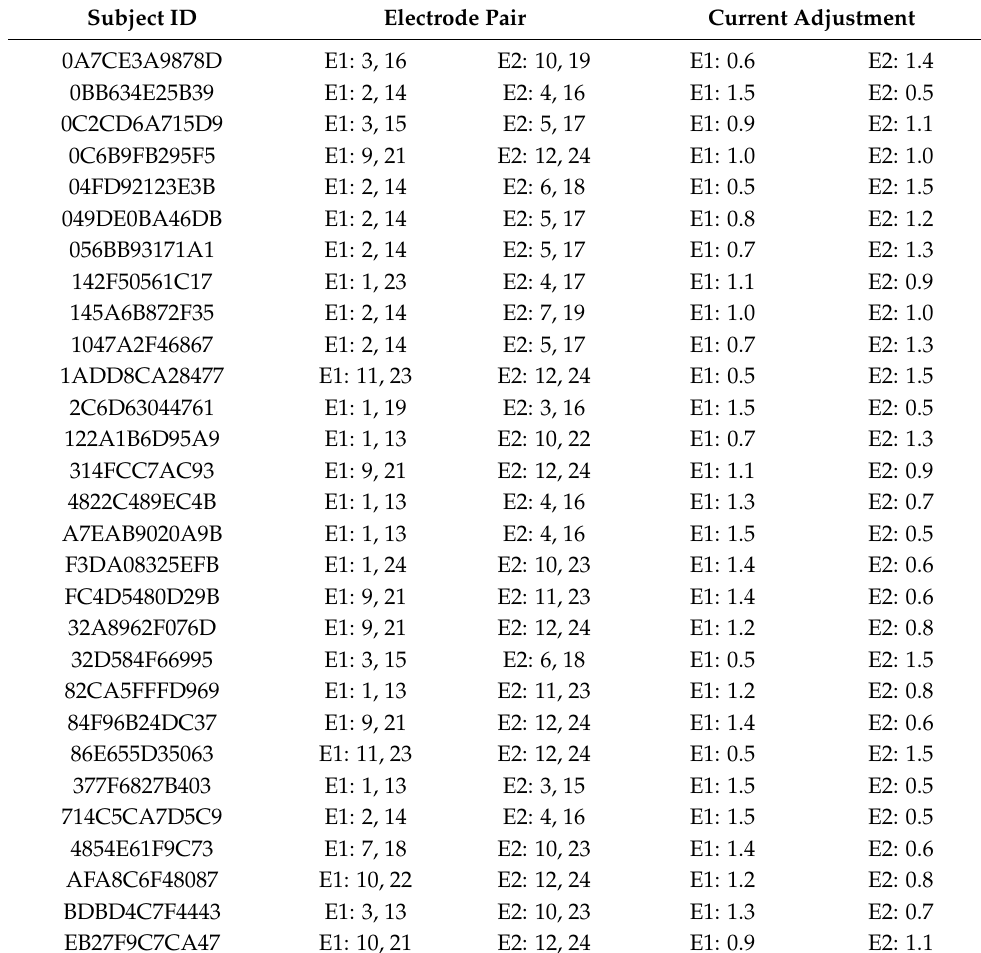
Table 4. Optimization parameter settings for intensity opt